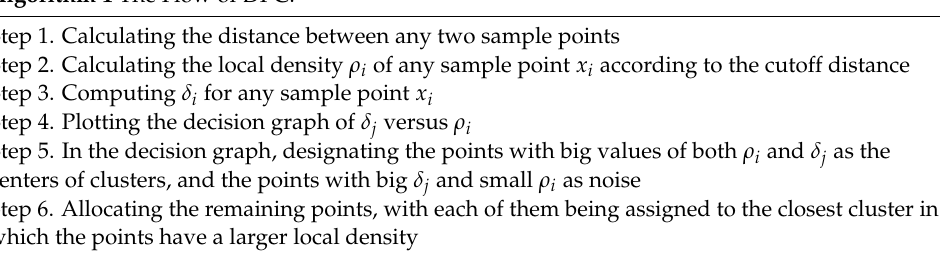
Algorithm 1 The Flow of